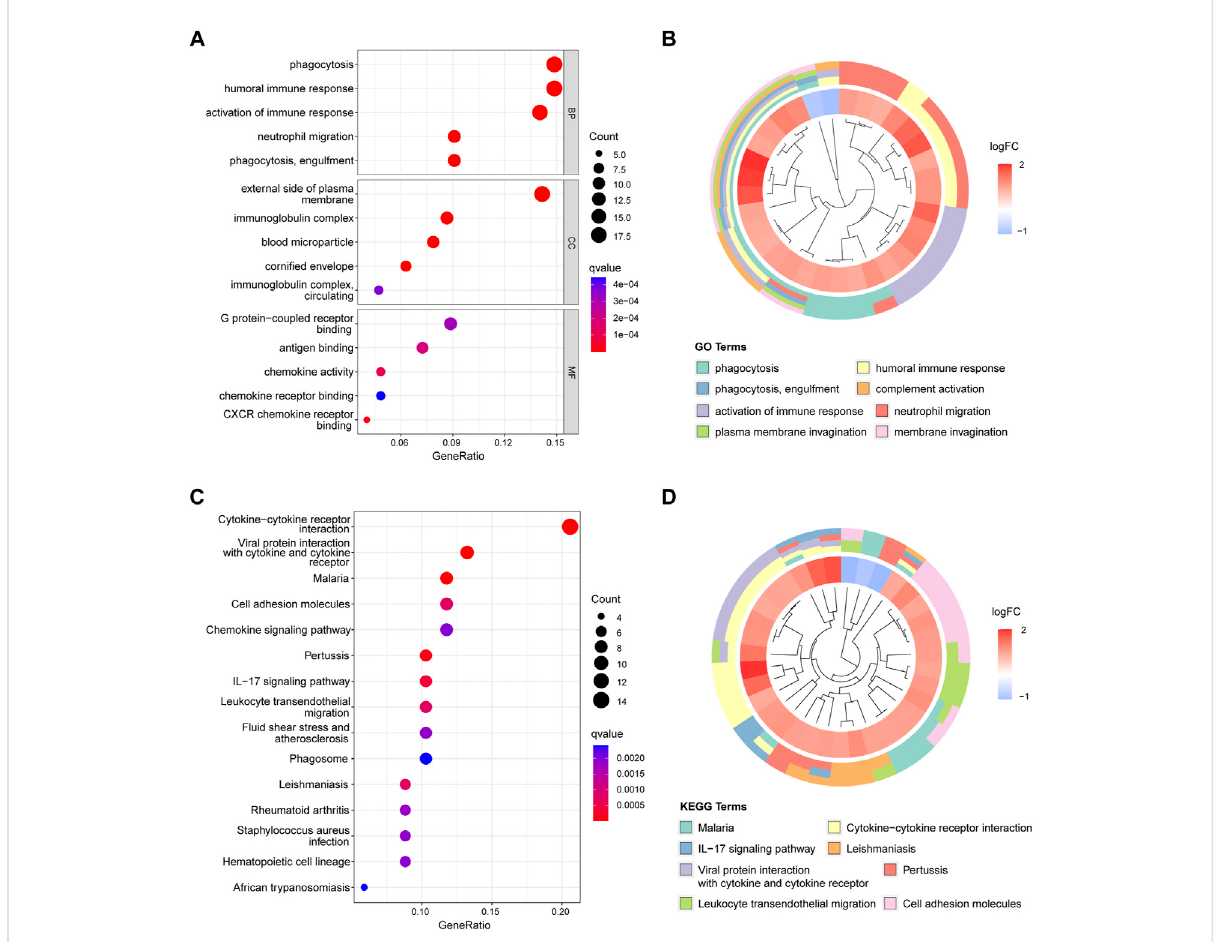
FIGURE 3 Figure3,Functionalenrichmentanalysisresults. (A) Top fi veenrichedGOtermsinbiologicalprocess(BP),cellcomponents(CC),andmolecular function (MF). (B) Top eight enriched GO terms difference in periodontitis. (C) Top 15 enriched KEGG signaling pathways. (D) Top eight enriched KEGG pathways difference in